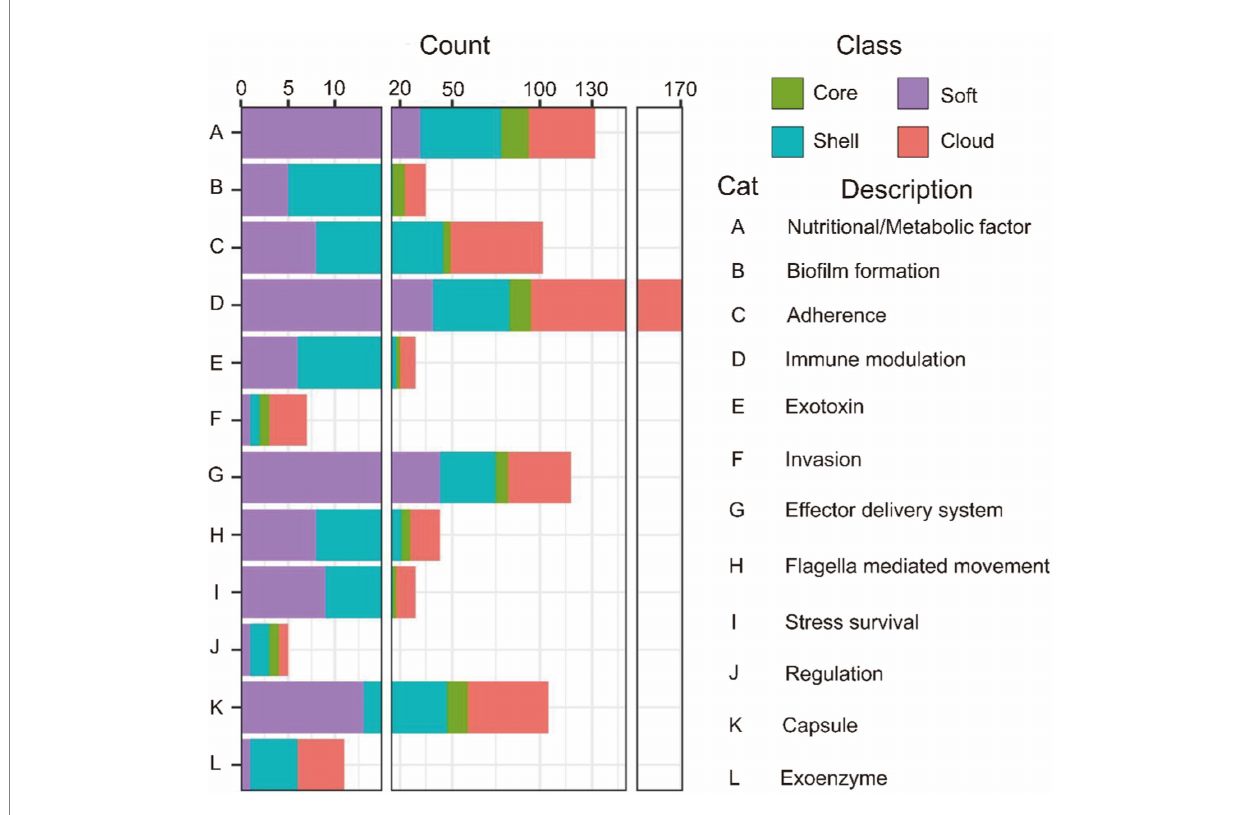
FIGURE 3 VFDB annotation of the core genome and the accessory